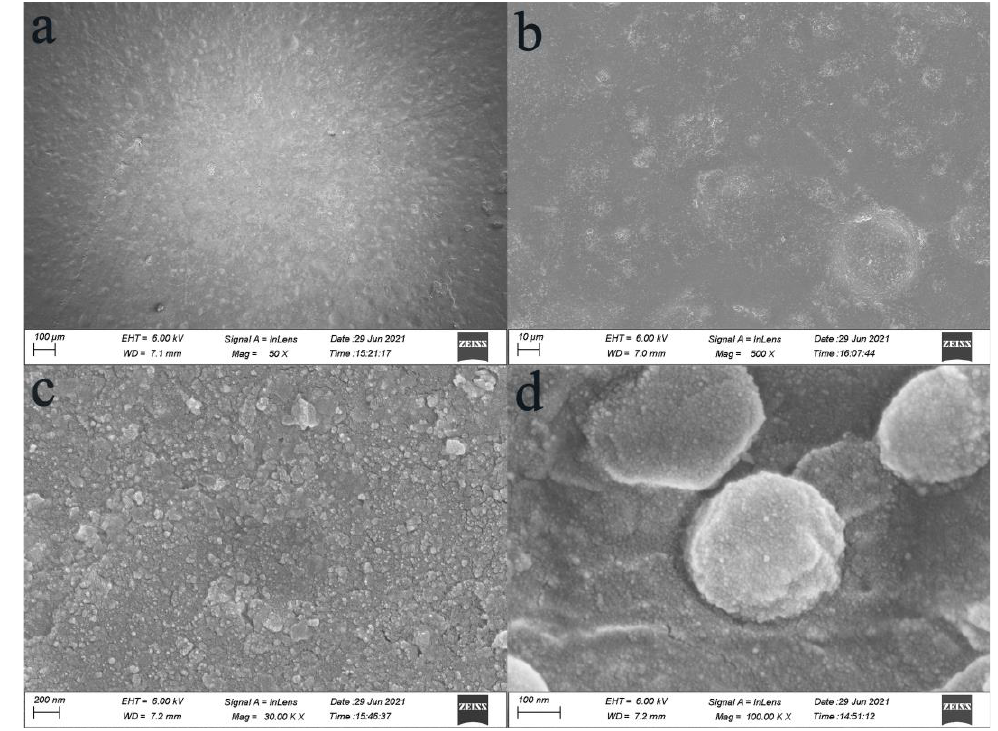
Figure 2. SEM images of the modified nanoscale titania coating: ( a , b ) overall appearance, ( c ) distribution of particles, ( d ) single particle.